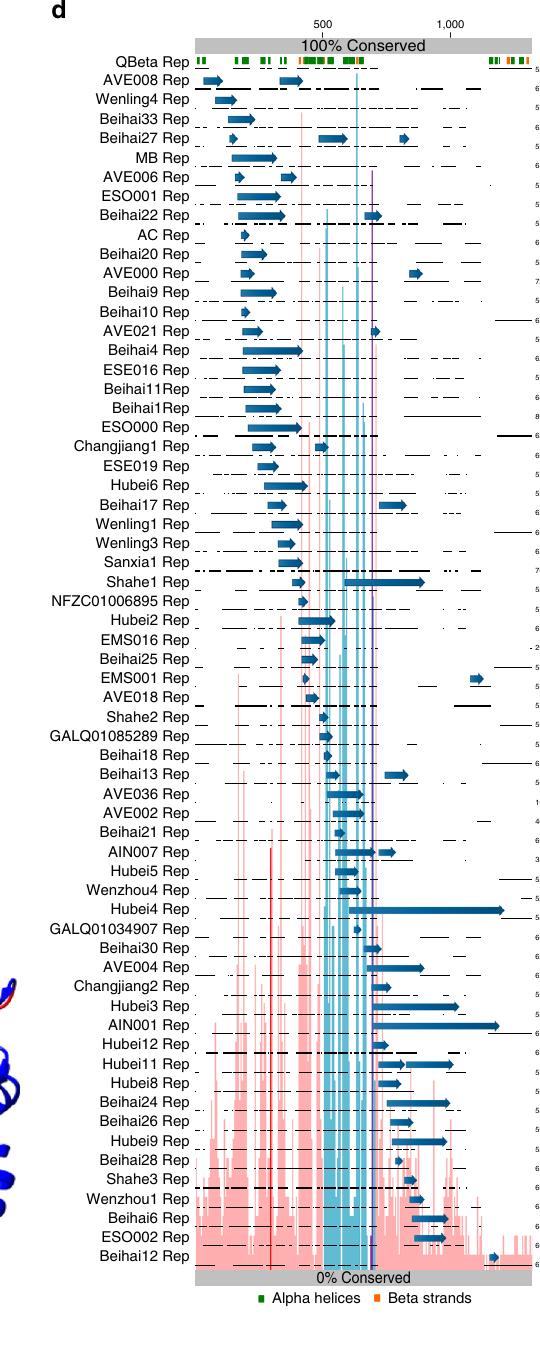
0% Conserved Alpha helices Beta strands